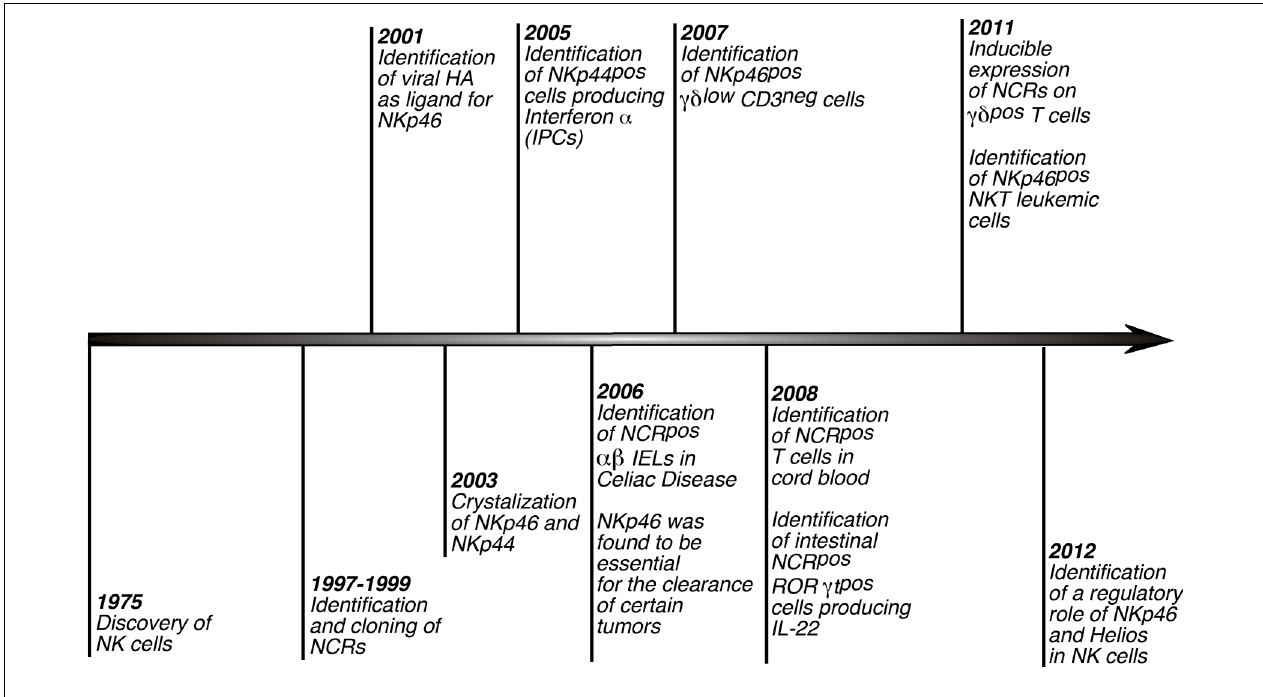
key role in triggering NK cell cytotoxicity and cytokine secretions, several studies lately reported that NCRs are expressed also on non-NK immune cells.